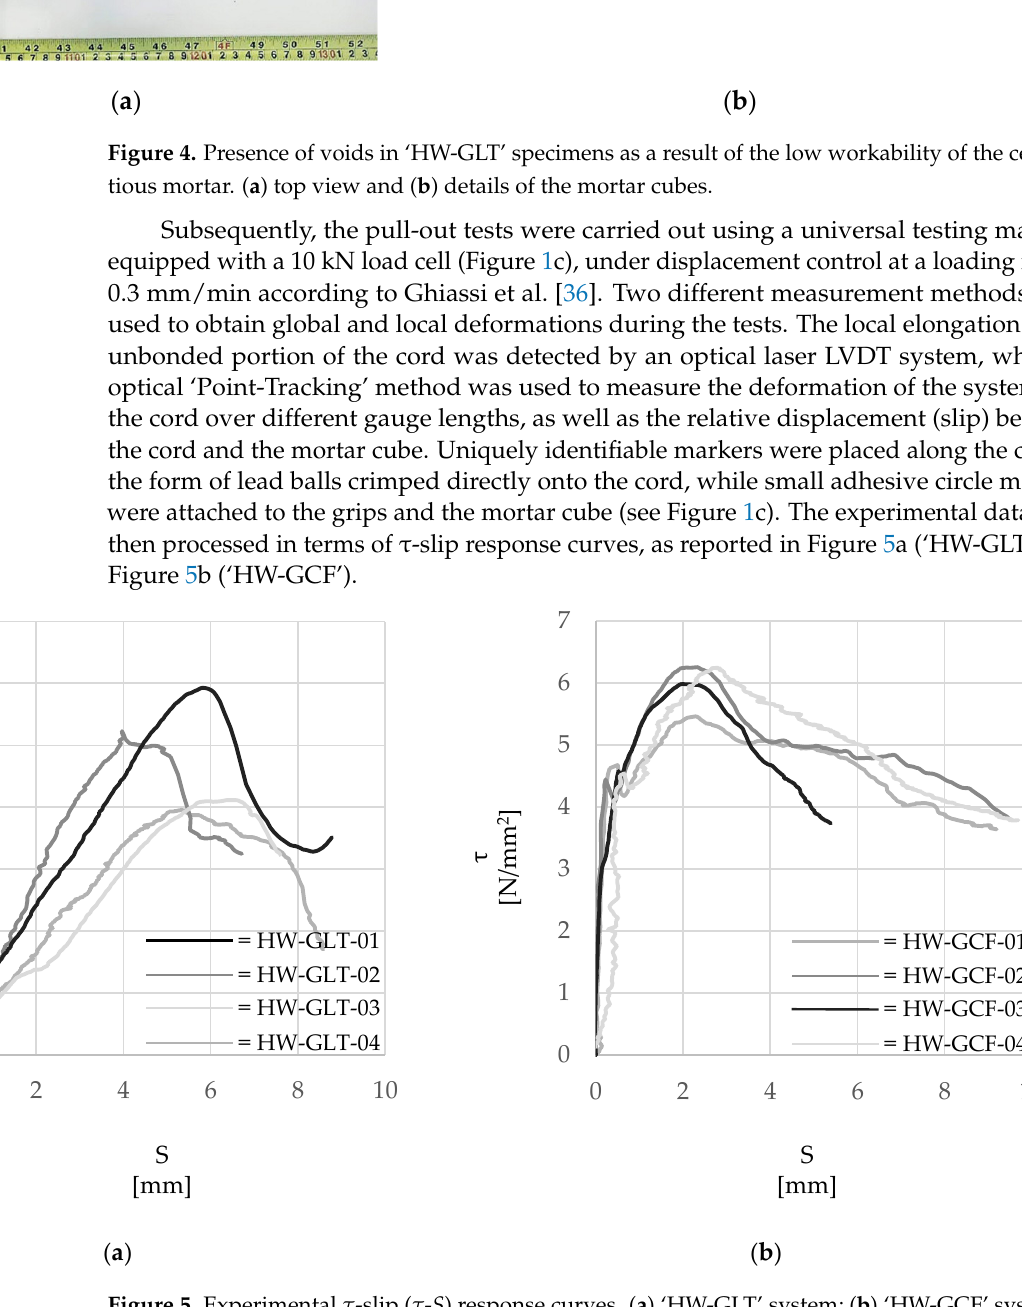
Figure 5. Experimental τ-slip (τ-S) response curves. ( a ) ‘HW-GLT’ system; ( b ) ‘HW-GCF’ system. The average bond stress ‘τ’ is defined according to Equation (1). The slip of the rein- forcement (S) relative to the mortar is determined by measuring the relative displacement between a marker placed on the mortar cube and a marker placed along the unbonded